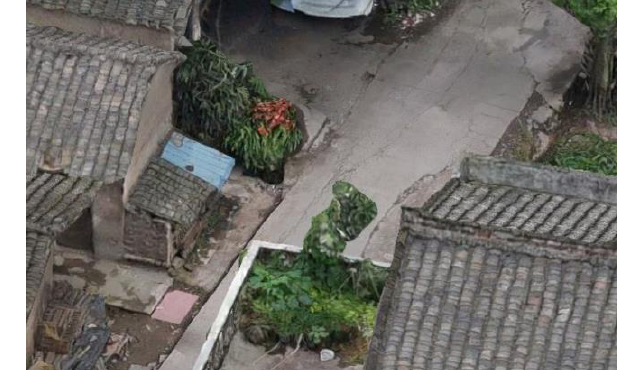
Figure 7. texture deformation